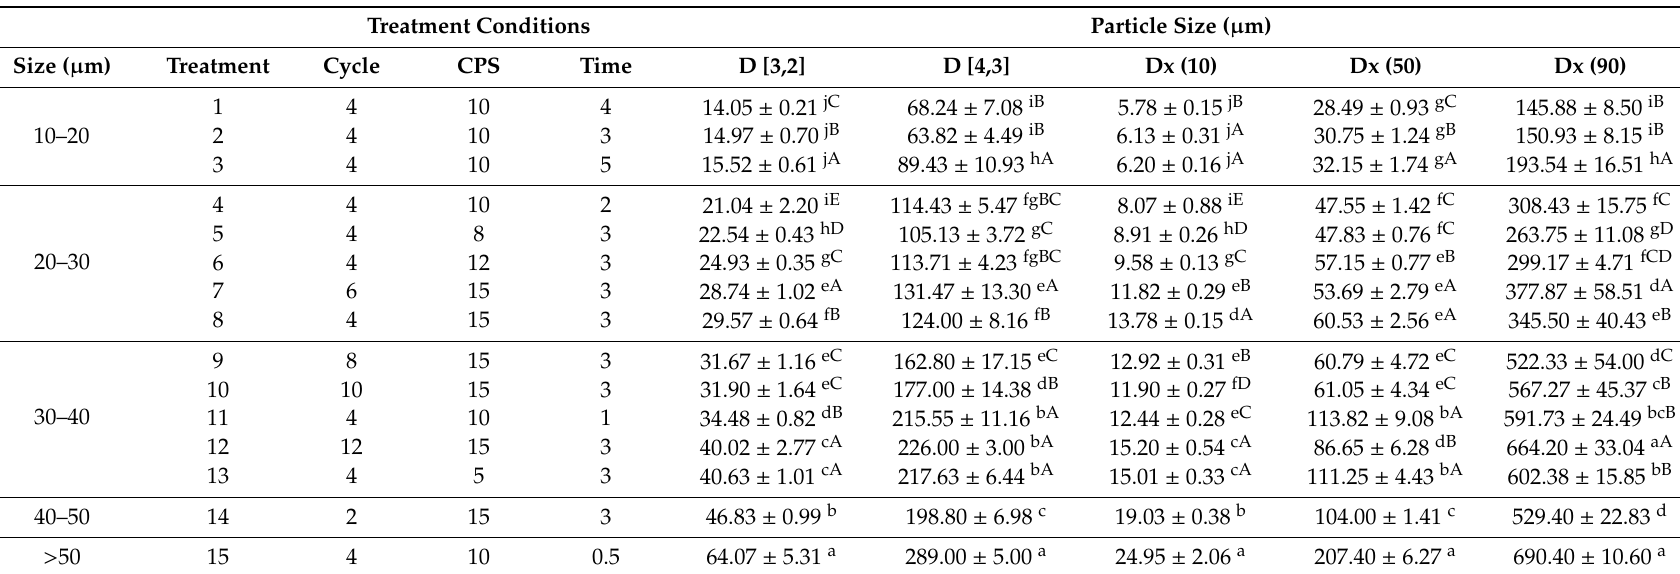
Table 1. Treatment of dried ginseng powder by particle size with various cryogenic milling